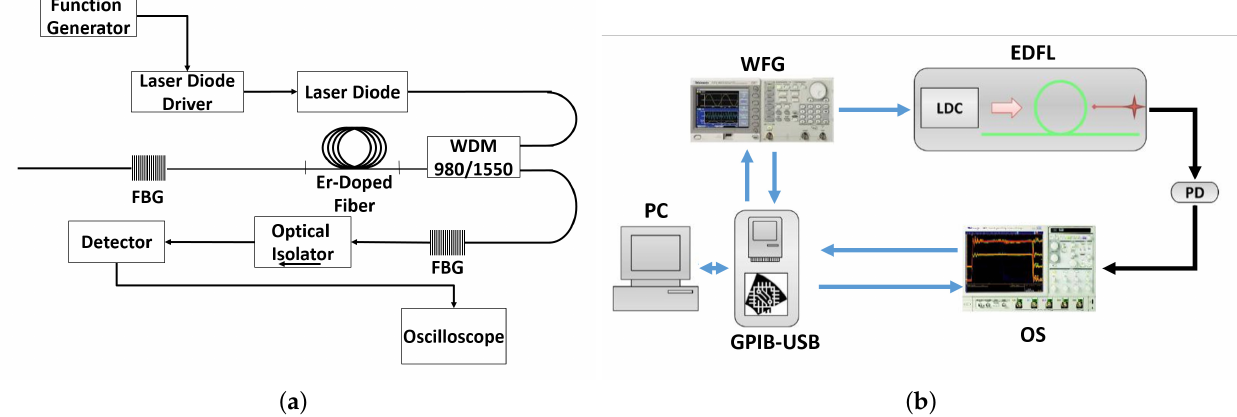
Figure 2. Experimental setup. ( a ) Optical elements required to put the Erbium-Doped Fiber Laser into operation ( b ) Elements required to implement the logic gate based on the operation of the